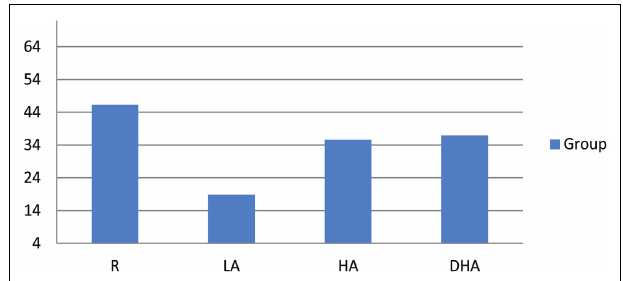
FIGURE 1 | Mean total OAS scores for R, LA, HA, and DHA.